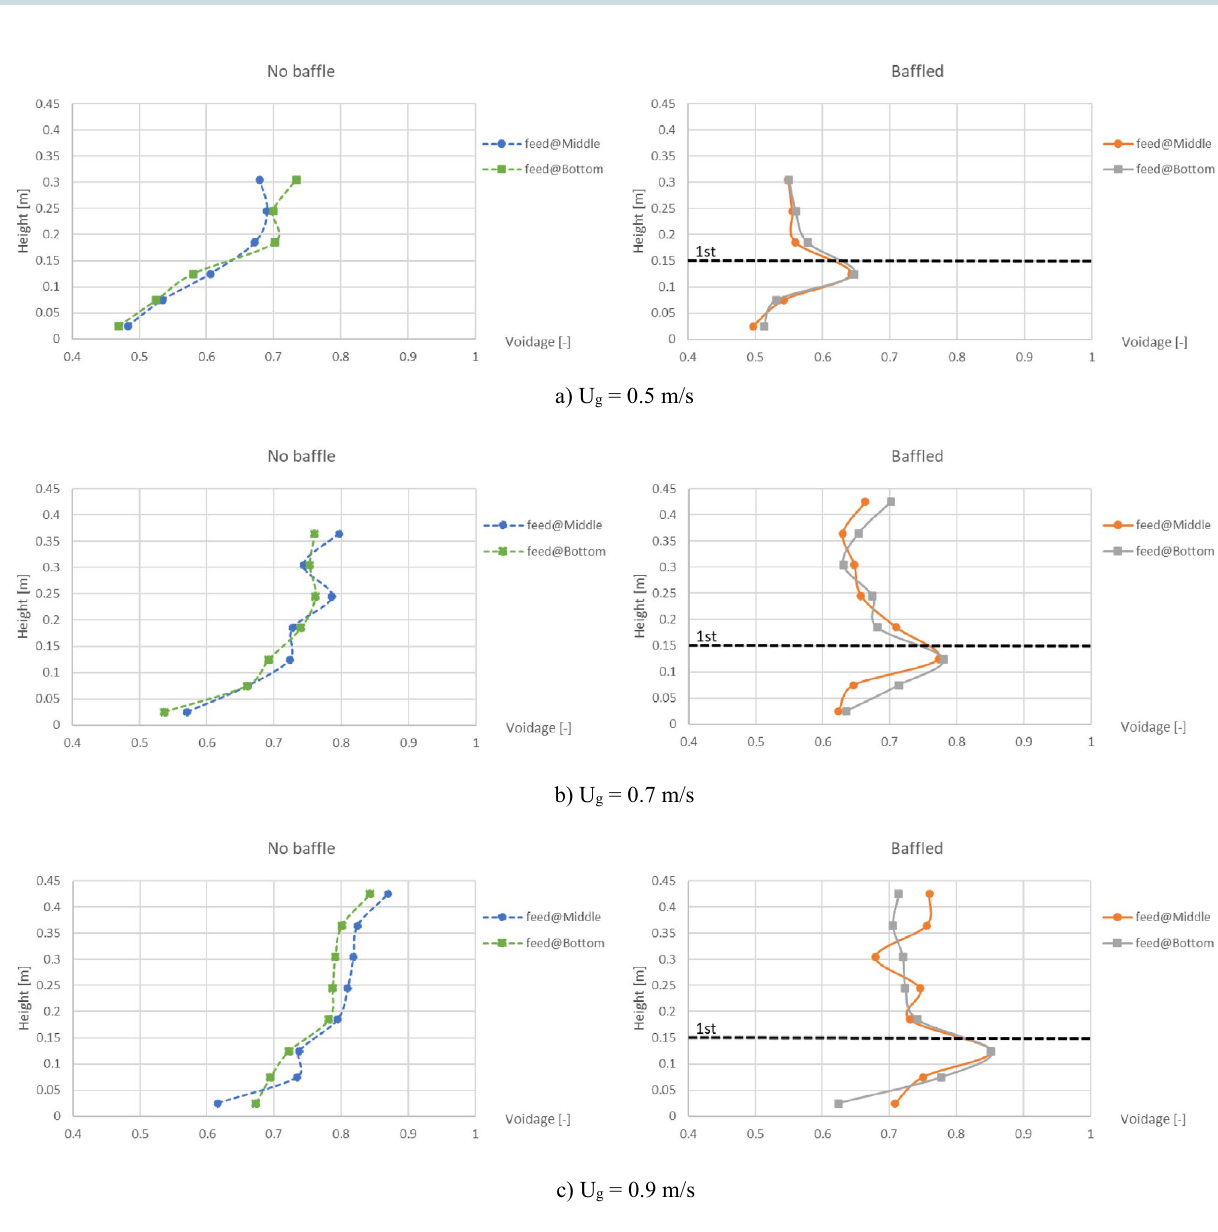
Figure 9. Effect of biomass feed position on maximum of cross-sectional averaged voidage in bed inside the no-baffle gasifier (left) and the baffled gasifier (right), when operating at various gas inlet velocities.